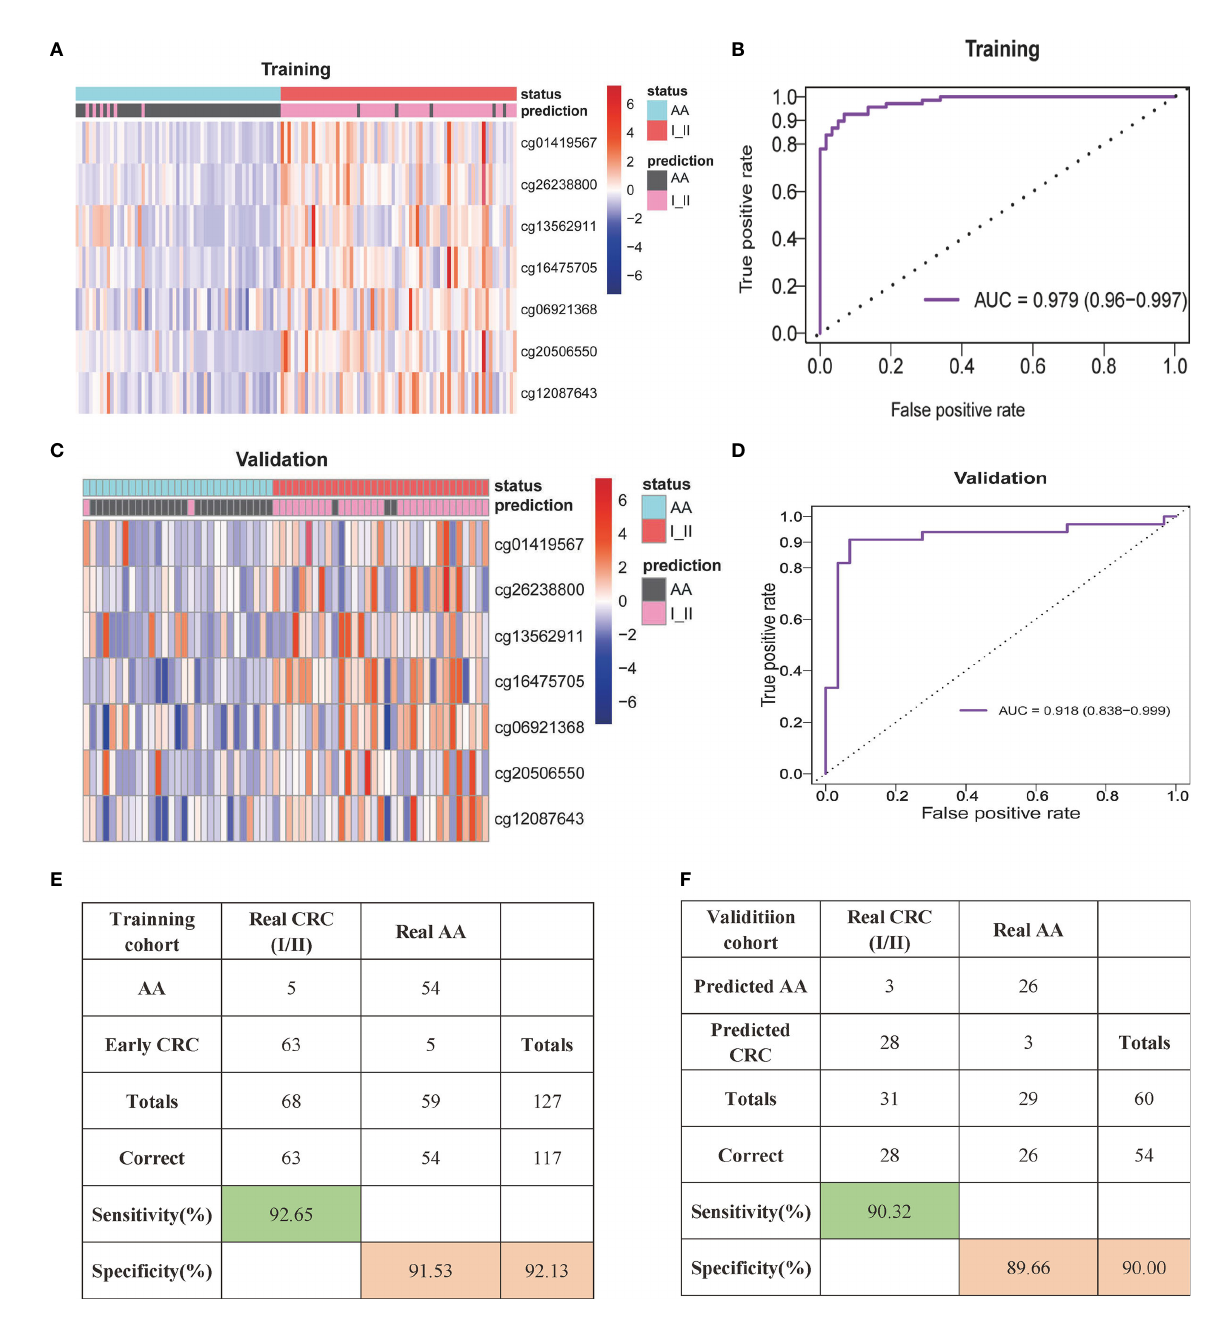
in Figure 5A ), with AUCs of 0.868, 0.703, 0.637 and 0.74, respectively. In particular, none of the stage I CRC patients in validation cohort were identi fi ed based on the assessment of the serum CEA level, and only one was identi fi ed based on the CA199 level. However, the model predicted 14 of 16 CRC patients (87.5%) both the CEA and CA199 levels (93.75% vs. 40% and 88% vs. 42%).